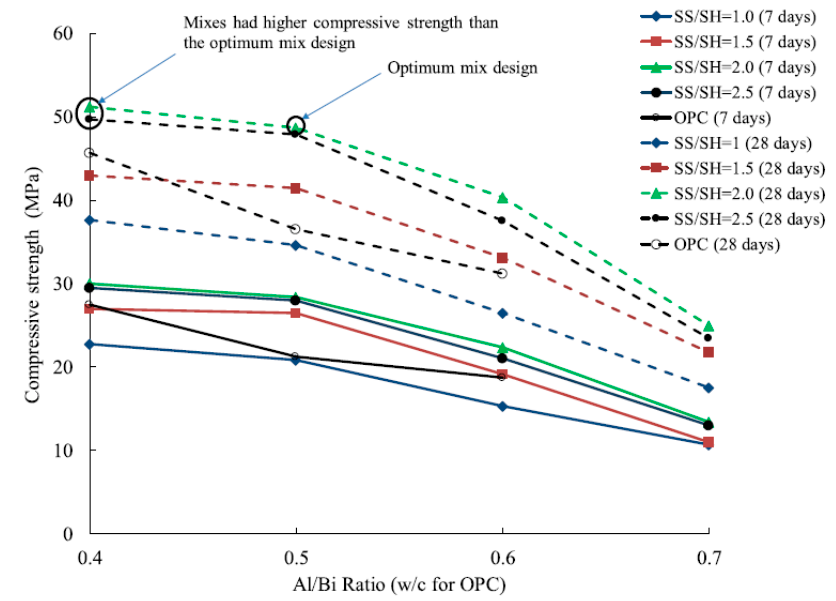
Figure 4. Effect of ground granulated blast furnace slag (GGBFS) content on the compressive strength of geopolymer pastes [41].